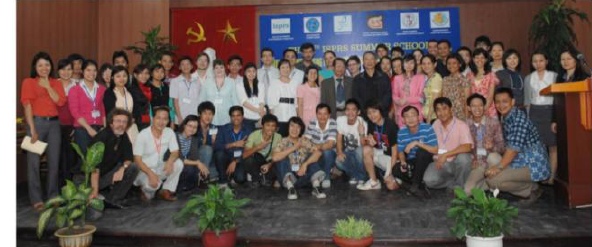
Figure 11. Groups picture from Taoyuan Summer School